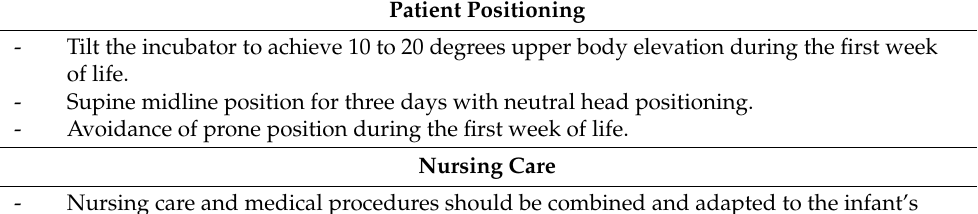
Table 1. Neonatal care bundle for the prevention of IVH (based on [20]). Patient